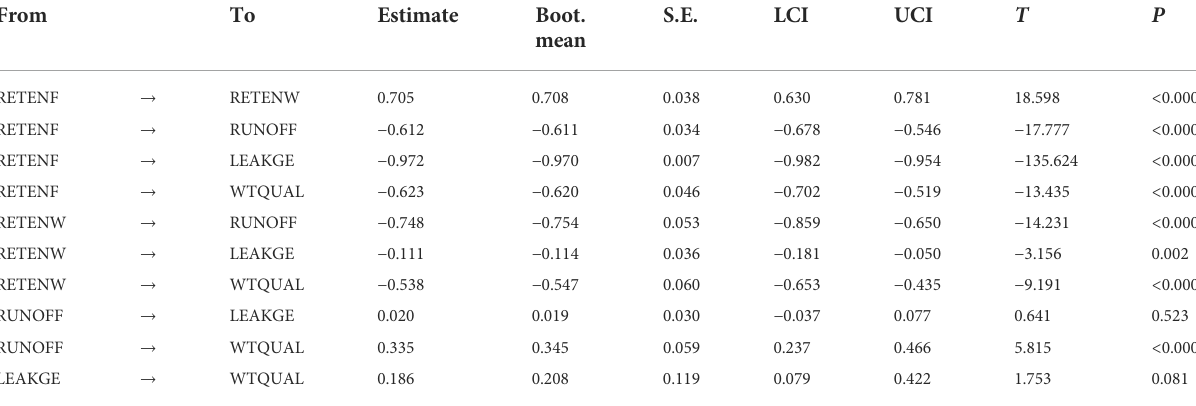
TABLE 7 Total effects of the fi nal (reduced variable) model, estimates denote whether an antecedent latent variable ( “ From ” column) positively or negatively affects the descendent variable ( ‘ To ’ column) while accounting for all paths connected through other latent variables (i.e., direct + indirecteffects).Pathweightsarepresentedasestimatesfrom500bootstrapestimates,accompaniedbyinterquartilecon fi denceintervals(LCI,UCI), associated T statistics and P - values. Effects that are not signi fi cant ( p < 0.05) are grayed out for clarity. From